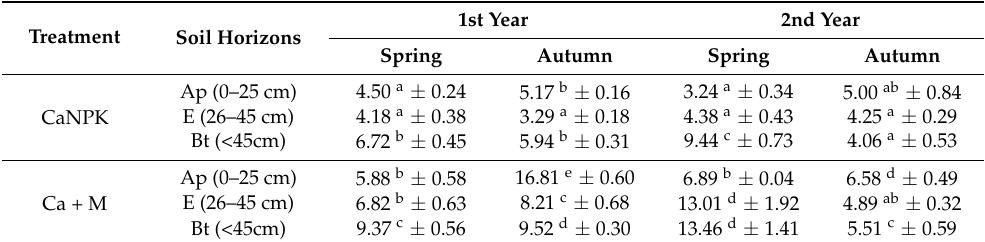
Table 2. Content of the dissolved organic carbon (DOC) in the soil (mg C kg − 1 ) in the spring and autumn of the 1st and 2nd